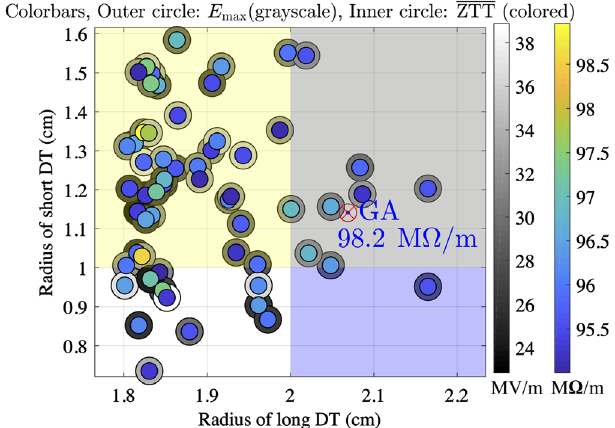
FIG. 12. Distribution of valid solutions obtained by a random search among 10,000 randomly generated parameter sets. All solutions with ZTT sp higher than 95.0 and a maximum surface electric field below 38 MV = m are plotted. The result of the genetic algorithm is shown as a red